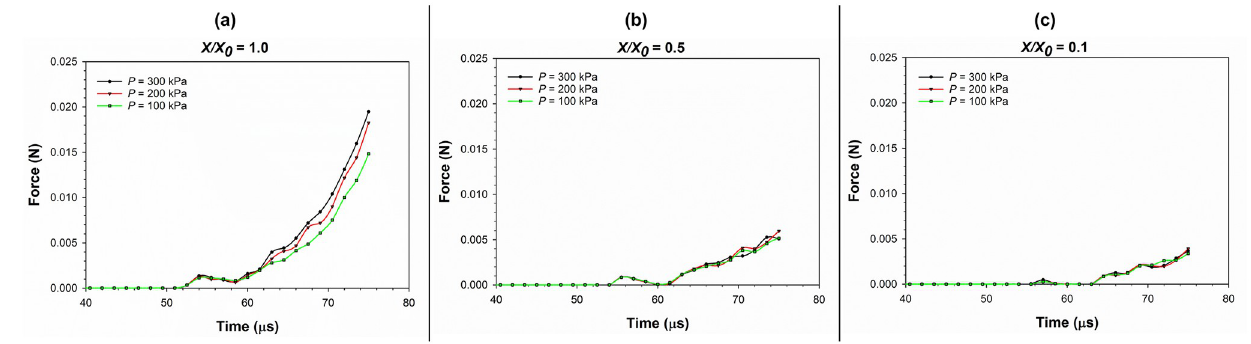
Fig 14. Variation of force on the compression plate with time during the cell compression simulation as affected by different turgor pressures. (a) = 1.0); (b) moderately dried cells ( X/X fresh cells ( X/X 0